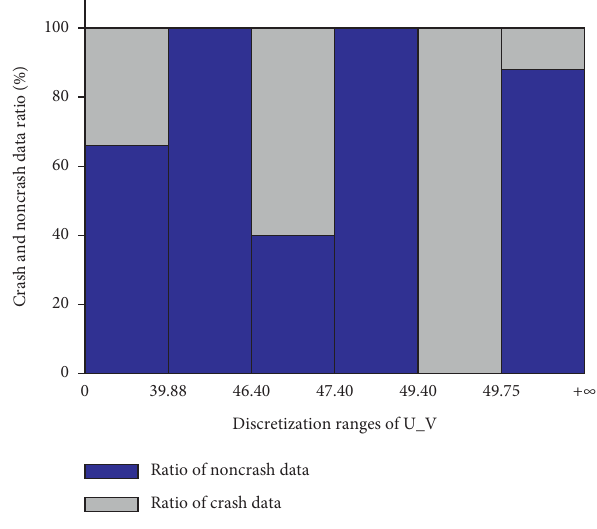
Figure 5: Discretization ranges of